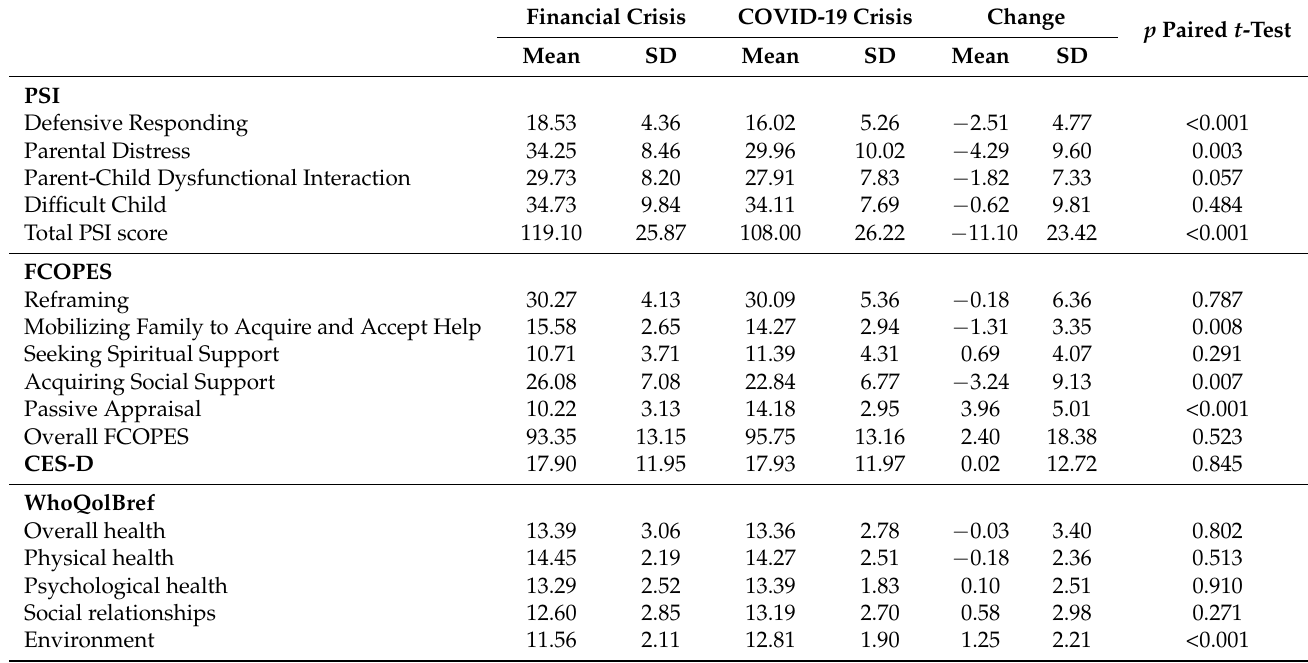
Table 2. Changes in PSI, F-COPES, CES-D, and WhoQolBref subscales from the financial to the COVID-19